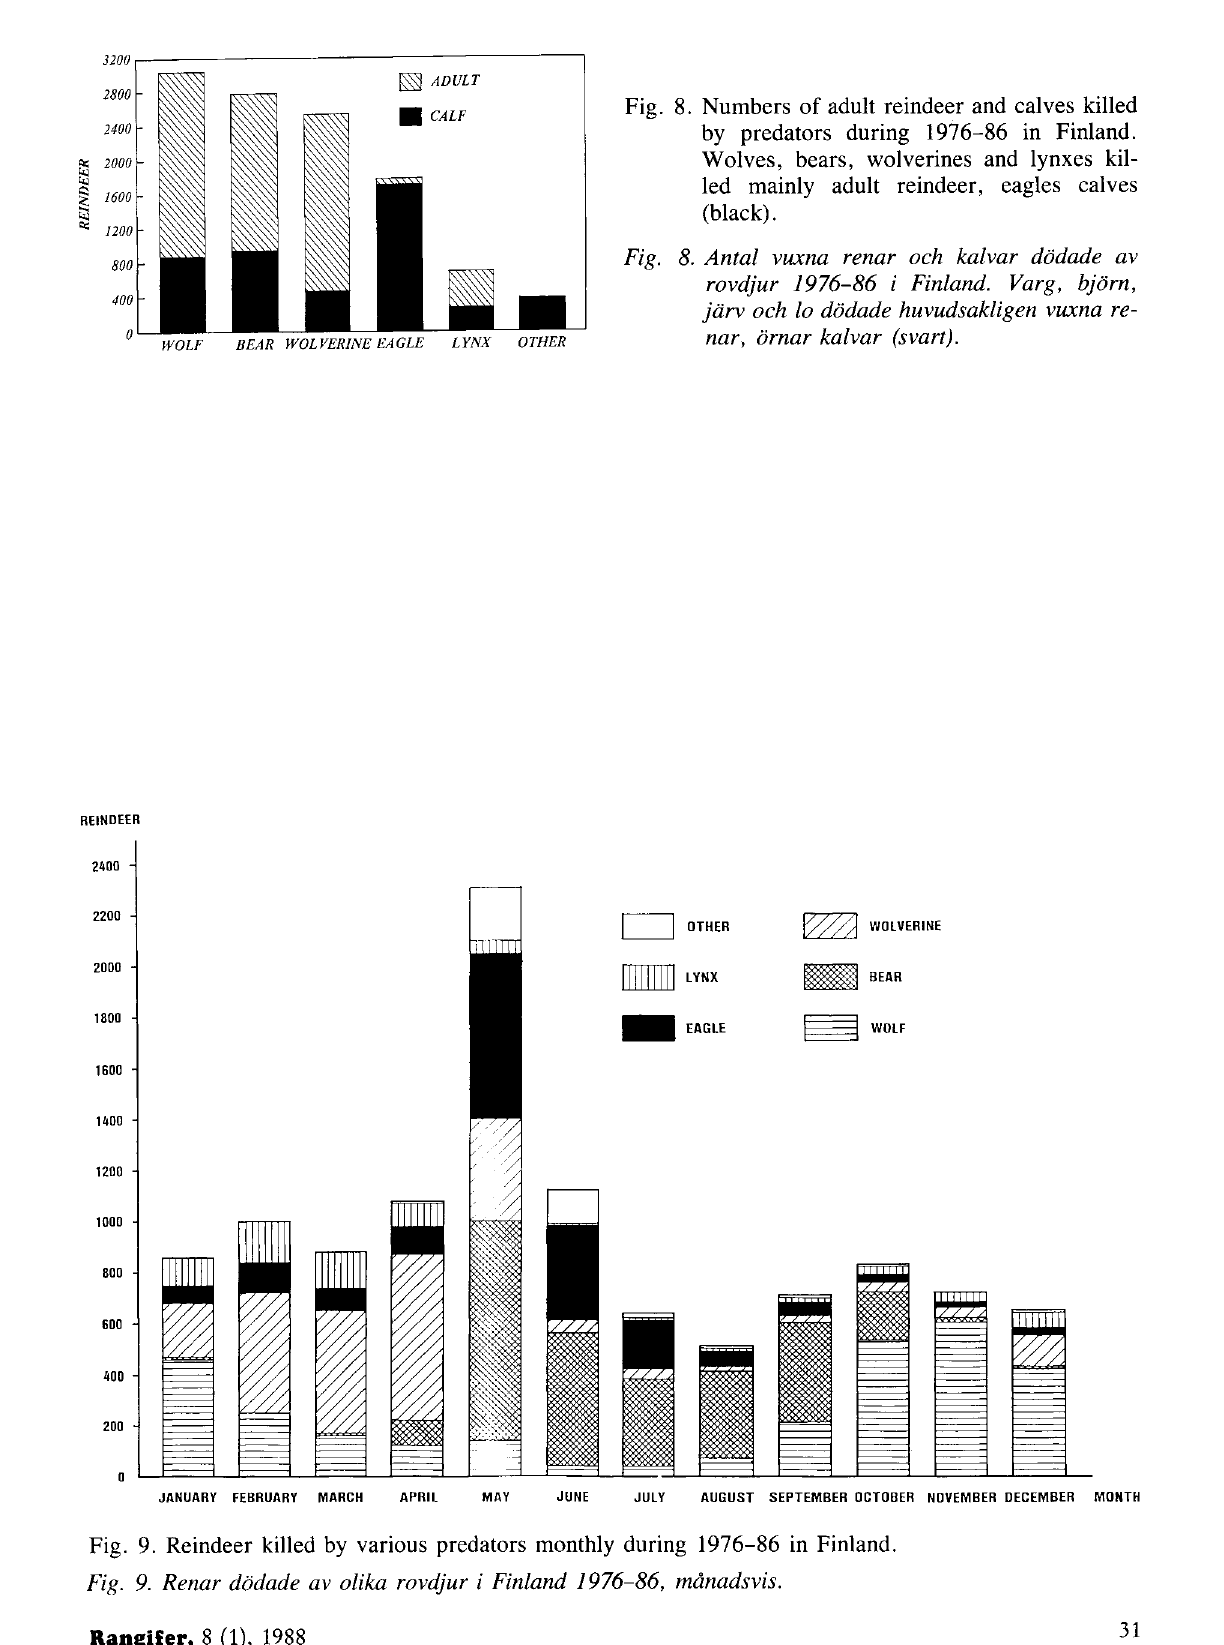
Fig. 9. Reindeer killed by various predators monthly during 1976-86 in Finland. Fig. 9. Renar dodade av olika rovdjur i Finland 1976-86, månadsvis. Rangifer, 8 (1),